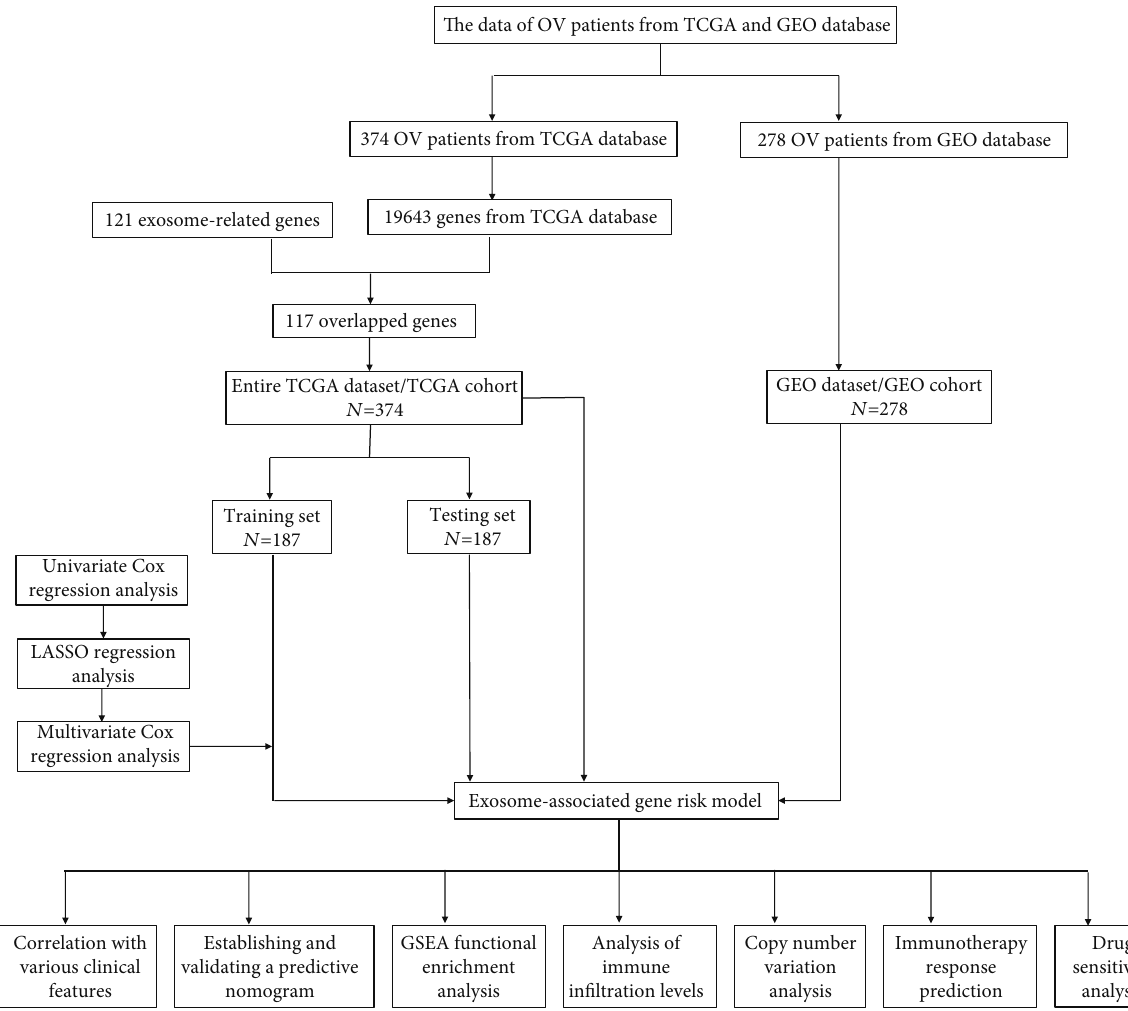
Figure 1: Flow chart of this